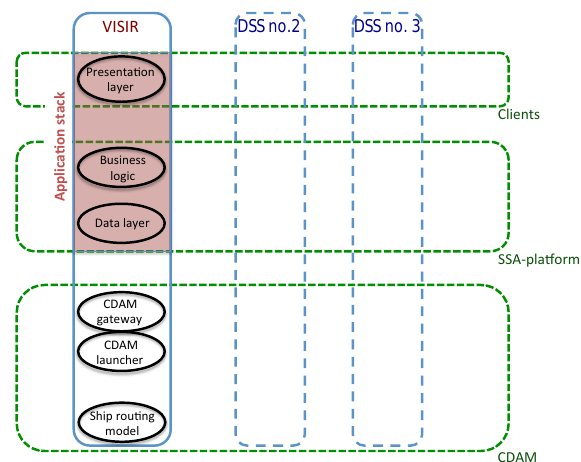
Figure 1. “TESSA matrix”: the three horizontal tiers and the verti- cal applications or DSSs. The red shaded area is the VISIR applica- tion